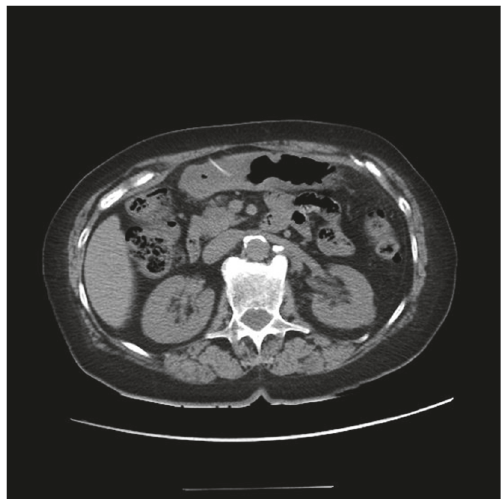
Figure 1: CT image of abdomen and pelvis without contrast, revealing a hyperdense, elongated, linear foreign body perforating the serosa of the stomach.